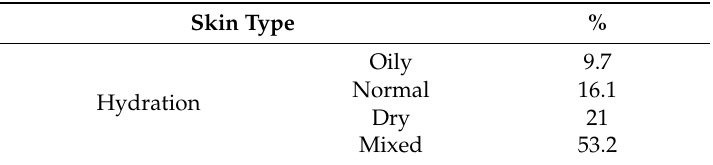
Table 3. Analysis of the skin type of the pilot study subjects, based on the subjects’ self-assessment of skin hydration, skin sensitivity, visible wrinkles and skin